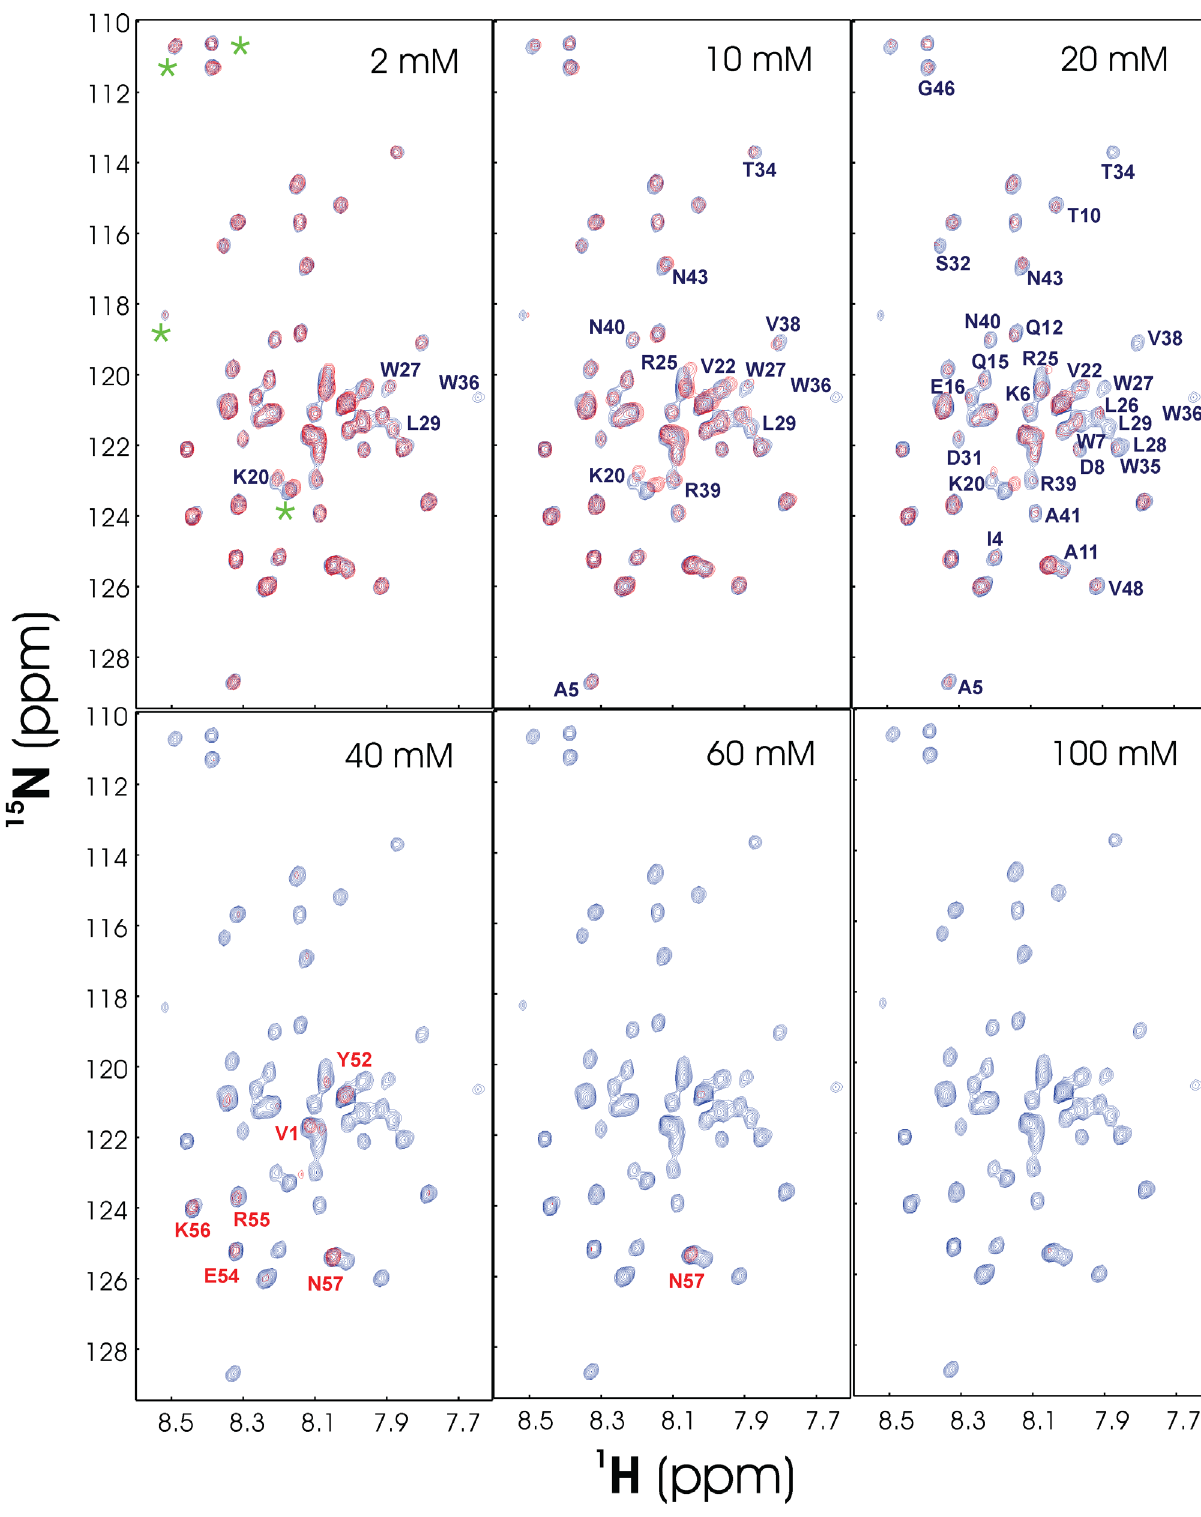
Figure 11. Titrations of V22-SH3 by NaCl salt as monitored by HSQC. Superimposition of the 1 H– 15 N NMR HSQC spectra of V22-SH3 at a protein concentration of 50 µM, solubilized in unsalted water (pH 4.0) (blue), and with gradual introduction of NaCl (red) to different concentrations. The HSQC spectra were acquired on an 800 MHz NMR spectrometer at 25°C. The blue font is used for labeling the residue with its HSQC peak intensity significantly reduced or disappeared, while the red is for the residue with its HSQC peak still observed.